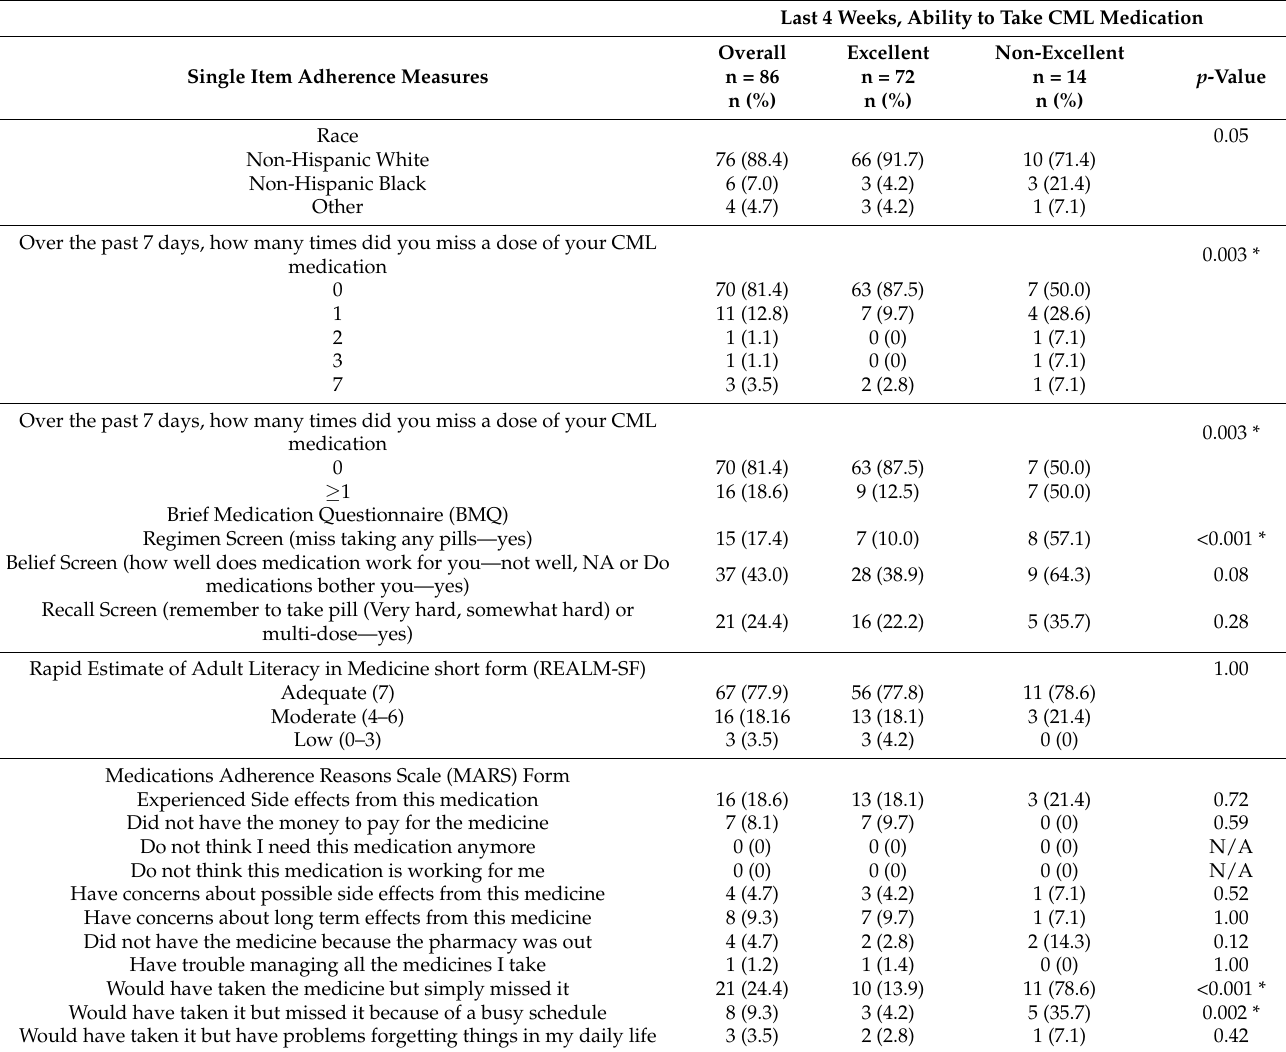
Table 3. Medication Adherence Single Item Questions: past 4 weeks among patients with chronic myelogenous leukemia (CML) who were prescribed oral